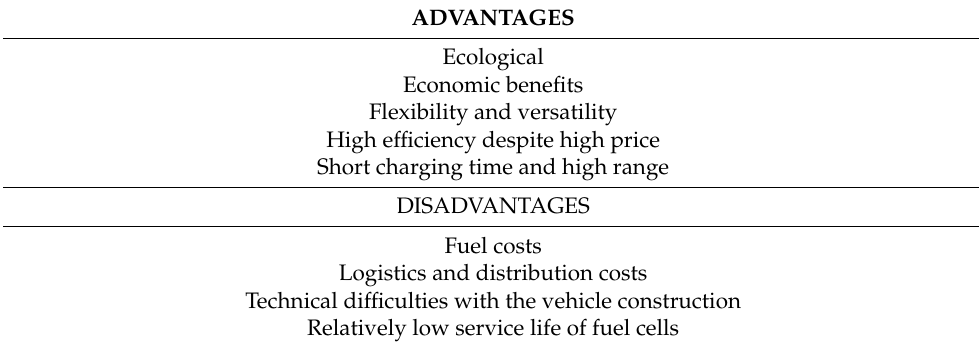
Figure 11. Graph of publications on hydrogen fuel cells vs. years (based on last 10 years of publications). They can also receive electricity from the recovery of energy generated during recu- peration. The fuel tanks are located on the roof of the vehicle, where compressed hydrogen is stored. Table 11 shows the advantages and disadvantages of hydrogen propulsion in rail transport. Table 11. Advantages and disadvantages of hydrogen propulsion in railway transport